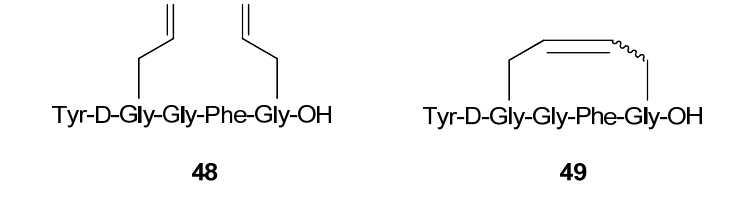
Figure 11. The cyclic ( E )-olefin 49 was found to be significantly more potent against opioid receptors than the acyclic precursor 48 .